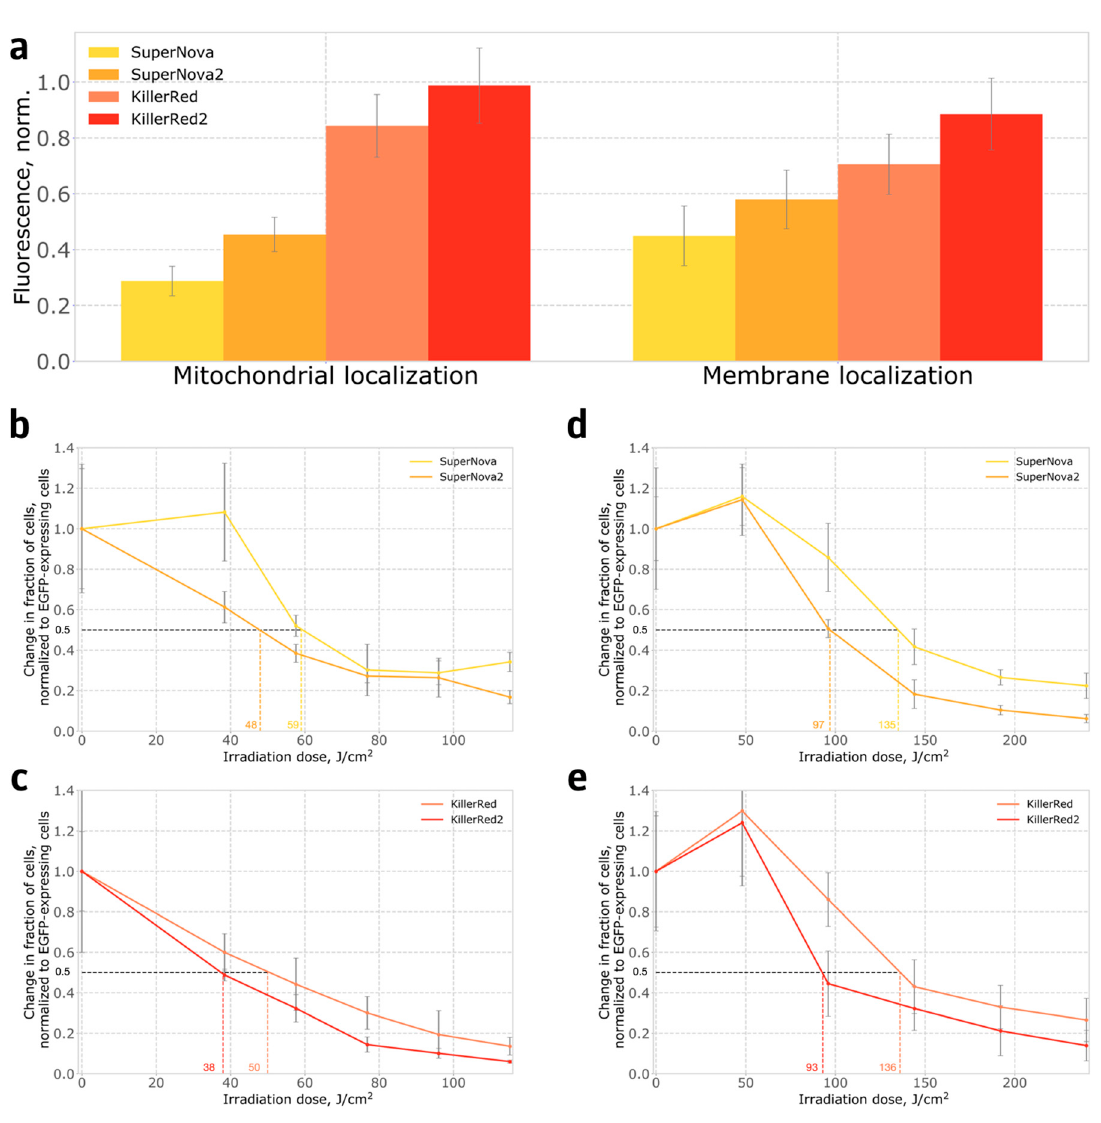
Figure 4. Expression of phototoxic fluorescent proteins in HeLa Kyoto cells: ( a ) Brightness of cells expressing phototoxic proteins targeted to mitochondria, or anchored in the cell membrane; ( b , c ) Phototoxicity of proteins targeted to mitochondria; ( d , e ) Phototoxicity of proteins anchored on the cell membrane. Indicative irradiation dose values required for ablation of 50% of cells are shown on the X axis in colour.